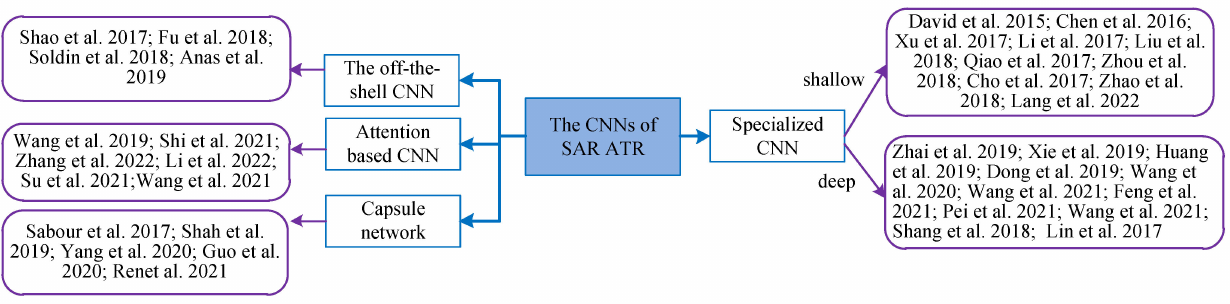
Figure 10. The CNNs in SAR ART